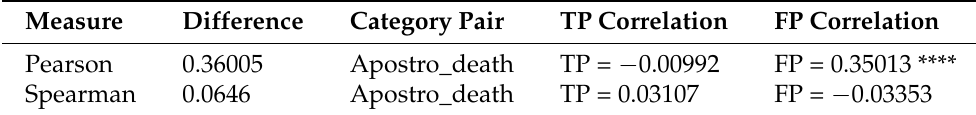
Table 18. Apostrophes and Death in